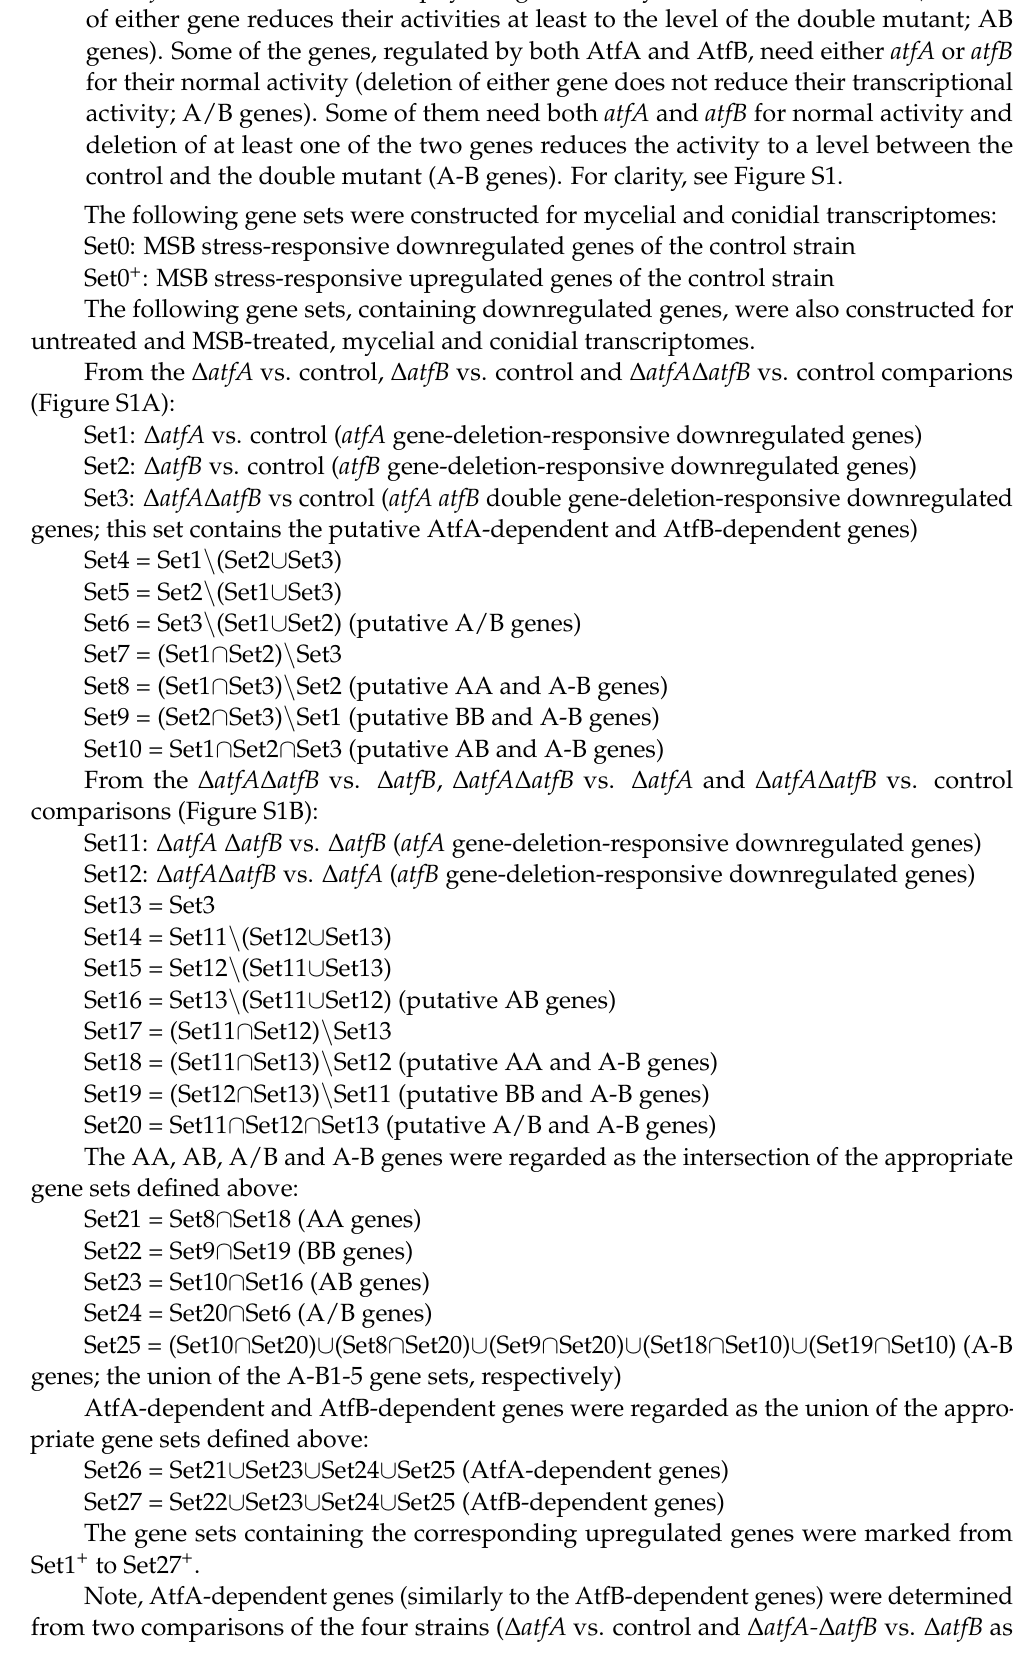
Set1: ∆ atfA vs. control ( atfA gene-deletion-responsive downregulated genes) Set2: ∆ atfB vs. control ( atfB gene-deletion-responsive downregulated genes) Set3: ∆ atfA ∆ atfB vs control ( atfA atfB double gene-deletion-responsive downregulated genes; this set contains the putative AtfA-dependent and AtfB-dependent genes) Set4 = Set1 \ (Set2 ∪ Set3) Set5 = Set2 \ (Set1 ∪ Set3) Set6 = Set3 \ (Set1 ∪ Set2) (putative A/B genes) Set7 = (Set1 ∩ Set2) \ Set3 Set8 = (Set1 ∩ Set3) \ Set2 (putative AA and A-B genes) Set9 = (Set2 ∩ Set3) \ Set1 (putative BB and A-B genes) Set10 = Set1 ∩ Set2 ∩ Set3 (putative AB and A-B genes) From the ∆ atfA ∆ atfB vs. ∆ atfB , ∆ atfA ∆ atfB vs. ∆ atfA and ∆ atfA ∆ atfB vs. control comparisons (Figure